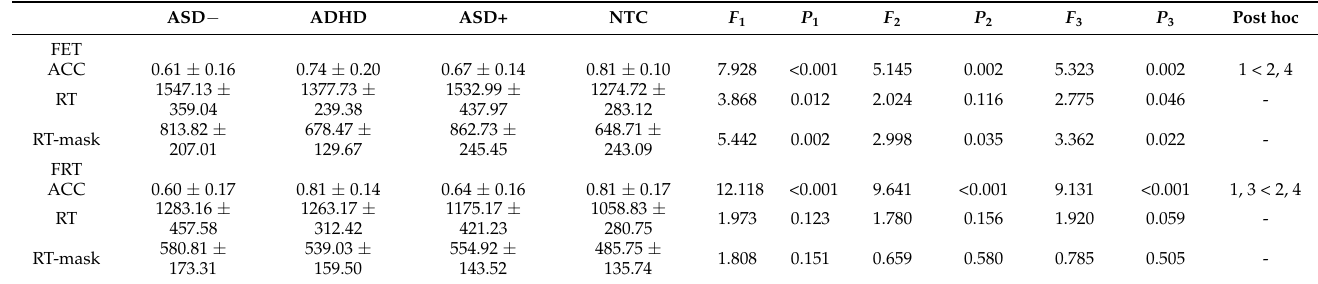
Table 2. Group differences in face encoding and retrieving performance.